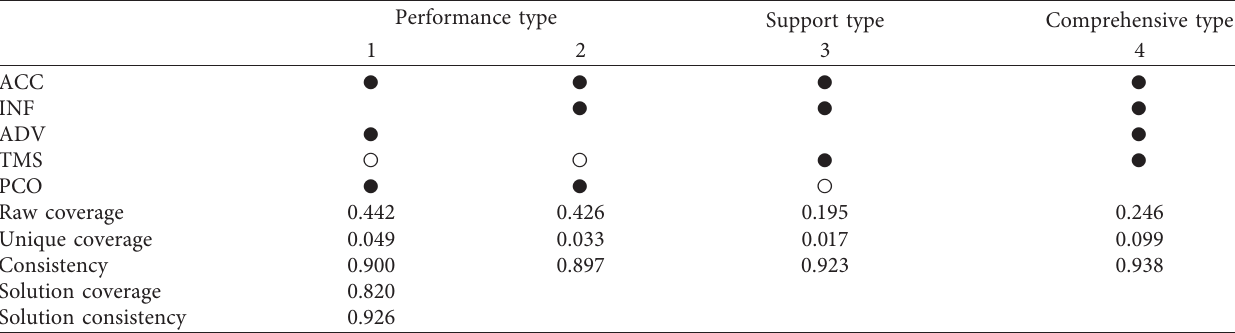
Table 5: BIM performance, project complexity, and BIM user satisfaction